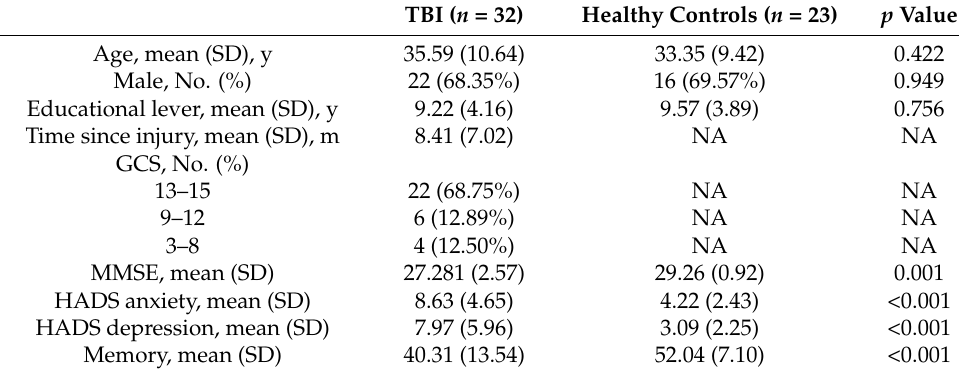
Table 1. The demographic and clinical characteristics in TBI patients and healthy controls.